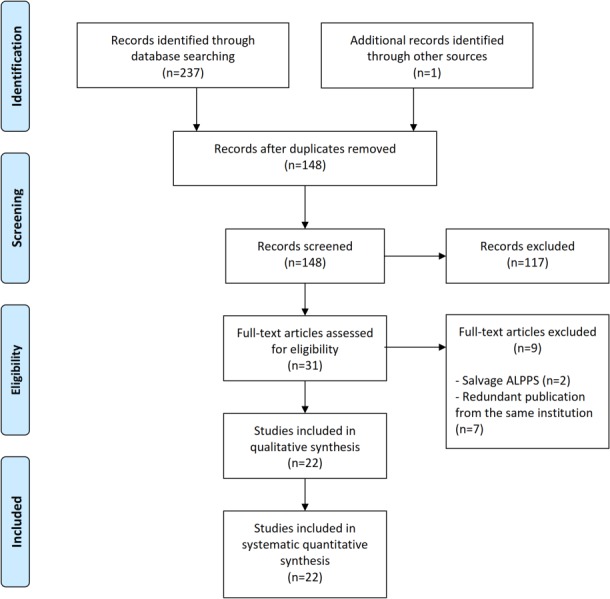
Study selection.